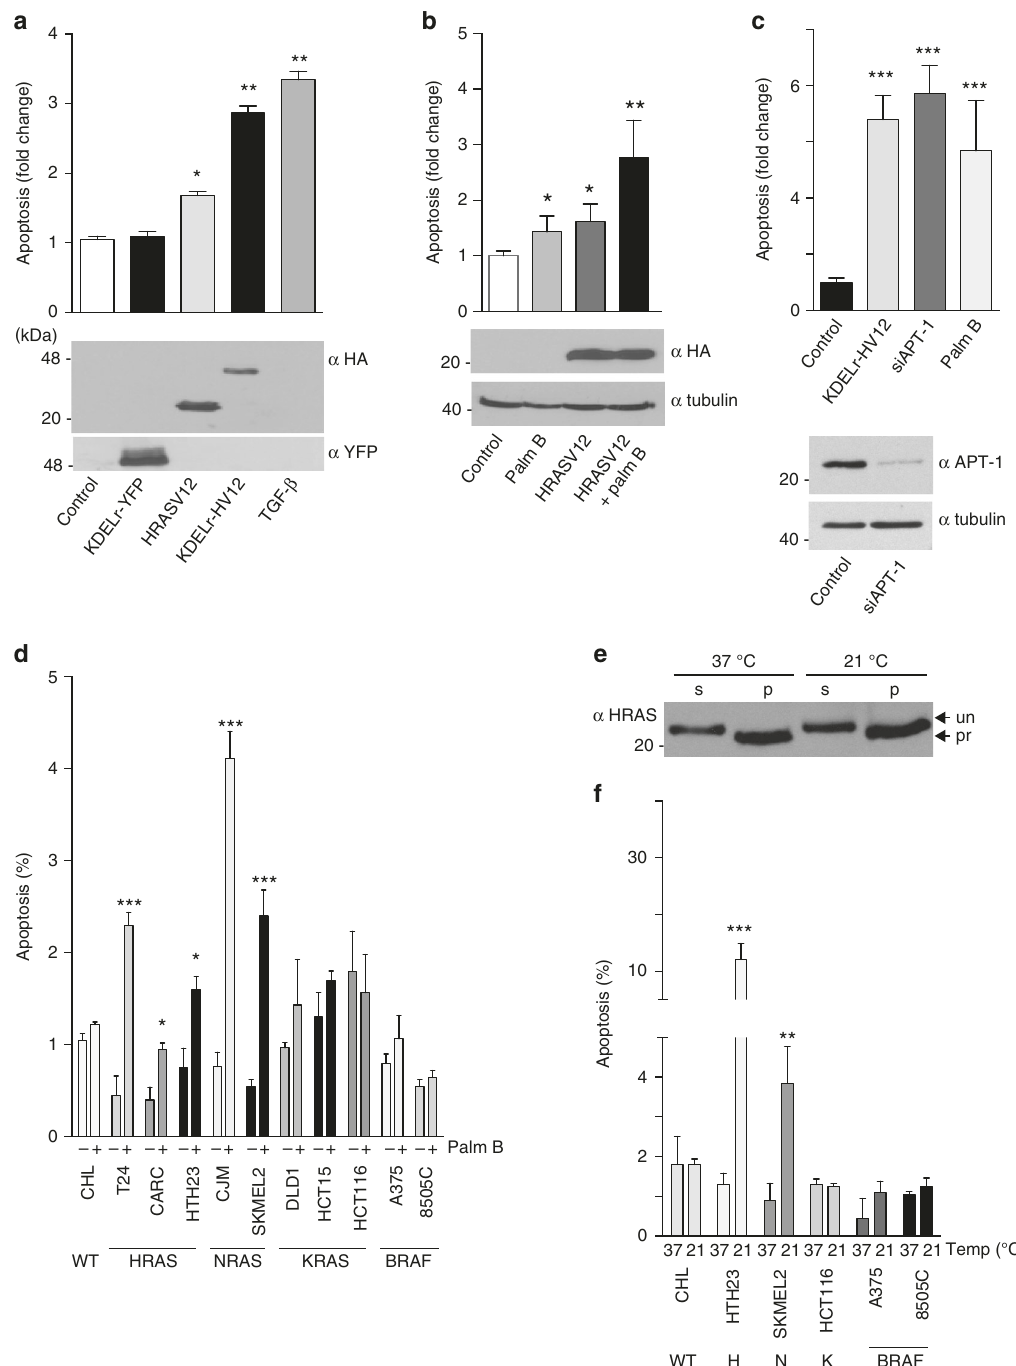
Fig. 3 Induction of apoptosis by RAS activation at the GC. a Induction of apoptosis in MCF-7 cells transfected with the indicated constructs (1 μ g each) or treated with TGF- β (5 ng/ml for 12 h). Apoptosis was evaluated by annexin V detection using the Guava/nexin assay. b Apoptosis in response to palmostatin B treatment (10 μ M, 24 h) in cells transfected with the indicated constructs (1 μ g each). c Apoptosis in response to APT-1 knockdown using a siRNA (100 nM). Lower panel: expression levels of APT-1 in control and siRNA-treated cells. d Apoptotic response to palmostatin B of tumor cells harboring the indicated oncogenes. WT = wild-type for RAS and BRAF. e Effects of temperature-dependent GC traf fi c blockade on RAS levels. RAS levels at the soluble (S) and particulate (P) fractions of SKMEL2 cells cultured at the indicated temperatures. Arrows (un/pro) indicate processed and unprocessed RAS forms. f Apoptotic response of tumor cells harboring different oncogenes to temperature-dependent GC blockade. Cells were kept at the indicated temperatures for 24 h. In all cases data show average ± SEM from 3 (A,B,C) or 5 (D,F) independent experiments. ns >0.05; * p < 0.05; ** p < 0.01; *** p < 0.005 by Student's t -test. See also Supplementary Figs. 2 –